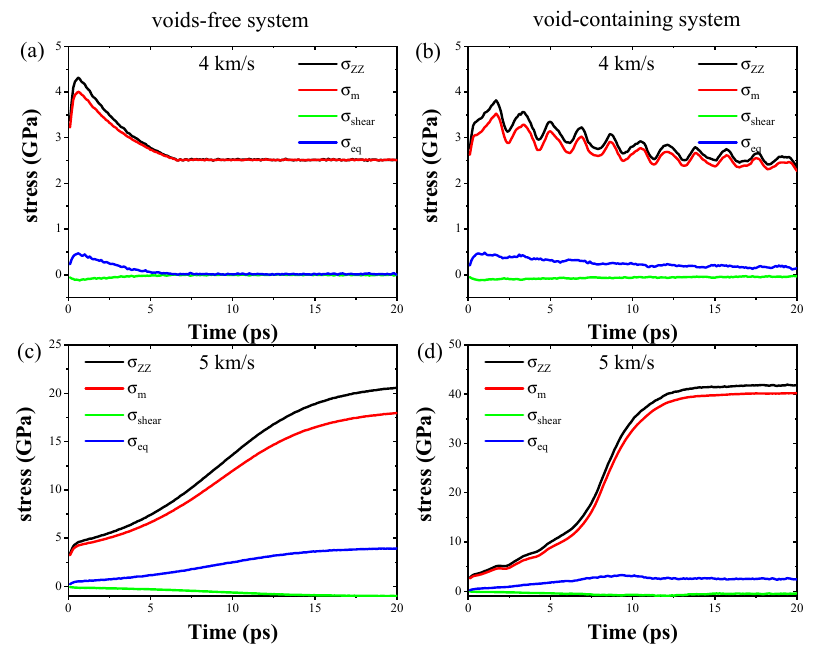
Figure 8. Time variation of stresses for ( a ) voids-free system and ( b ) void-containing system loaded by compressive shock waves with 4 km/s. Time variation of stresses for ( c ) voids-free system and ( d ) void-containing system loaded by compressive shock waves with 5 km/s.